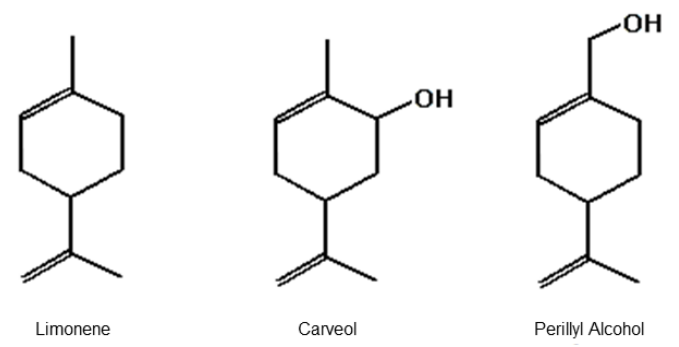
Figure 1. Chemical structure of the monoterpene limonene and monoterpenoids carveol and perillyl alcohol [8].